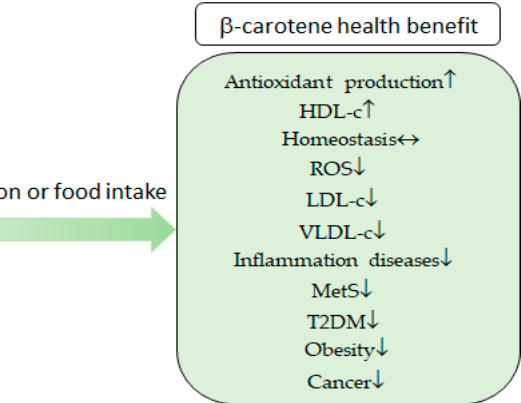
Figure 1. The roles of β -carotene consumption in the prevention of several metabolic diseases and health promotion. HDL-c—high-density lipoprotein cholesterol, ROS—reactive oxygen species, LDL-c—low-density lipoprotein cholesterol, VLDL-c—very-low-density lipoprotein cholesterol, MetS—metabolic syndrome, and T2DM—type 2 diabetes mellitus.